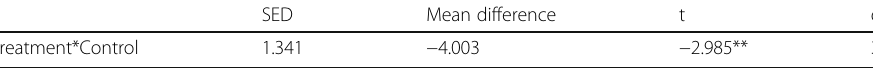
Table 2 Comparison of Reading Posttests across Groups SED Mean difference t df Treatment*Control 1.341 SED Standard error difference, ** p